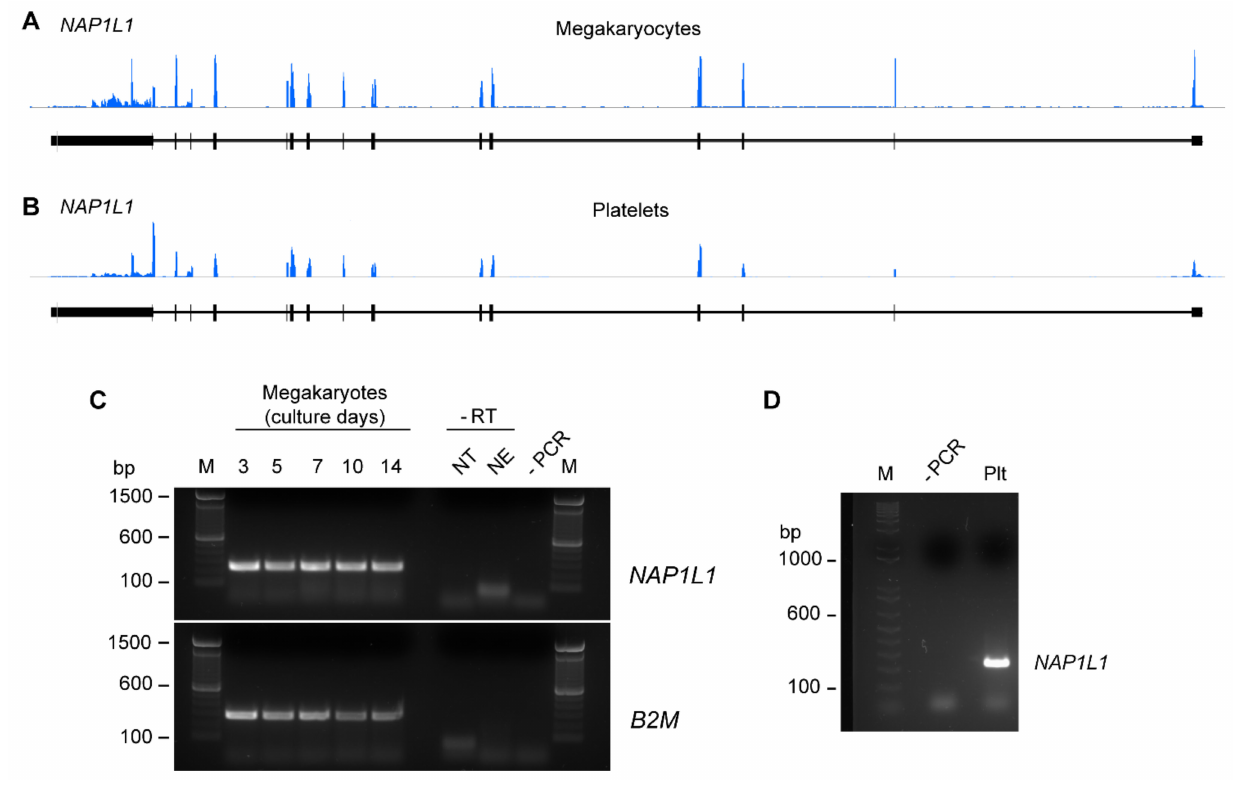
Figure 1. MKs and human PLTs express mRNA for NAP1L1. RNA-seq snapshots taken from the Integrated Genome Browser of the NAP1L1 transcript in CD34+-derived MKs ( A ) and human PLTs ( B ) (representative for n = 3). The height on the y -axis represents the relative accumulated number of reads spanning a particular sequence. The average of the read depths across all genomic coordinates within a transcript correlate to abundance of RNA expression. NAP1L1 transcript regions are represented below the plots by thick (exon) and thin (intron) lines. ( C ) MKs at culture days 3, 5, 7, 10, and 14 were examined for NAP1L1 expression by PCR. NT represents the reverse transcription (RT) reaction using no template, NE represents the RT reaction using no enzyme. Both controls were performed to control for contaminating nuclear DNA. Bottom , B2M as a loading control. This figure is representative of 5 independent experiments. ( D ) RNA from freshly isolated PLTs at baseline was isolated and NAP1L1 mRNA expression was evaluated by PCR. This figure is representative of 3 independent experiments. The -PCR lane shows the negative control for the PCR reaction, lanes labeled with M indicate the marker